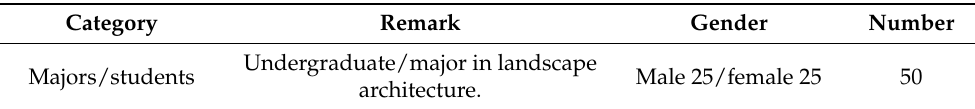
Table 4. Composition of the evaluators.